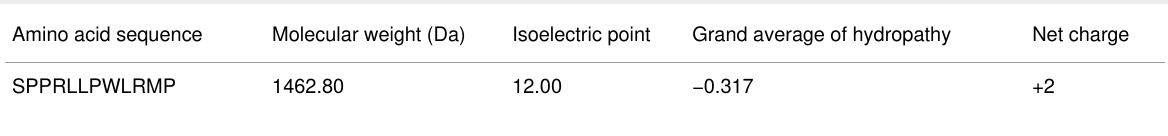
Table 1: Amino acid sequence and physicochemical properties of the SiBP. Amino acid